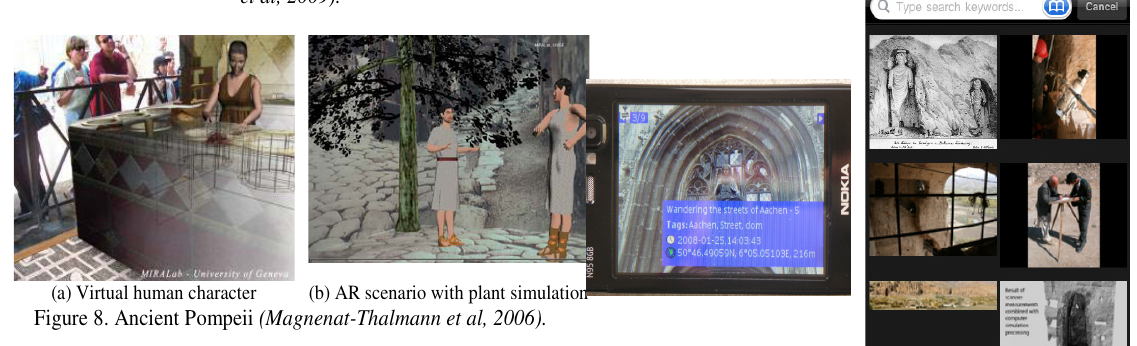
Figure 7. Ancient Olympic Games (Vlahakis et al, 2001 in Noh